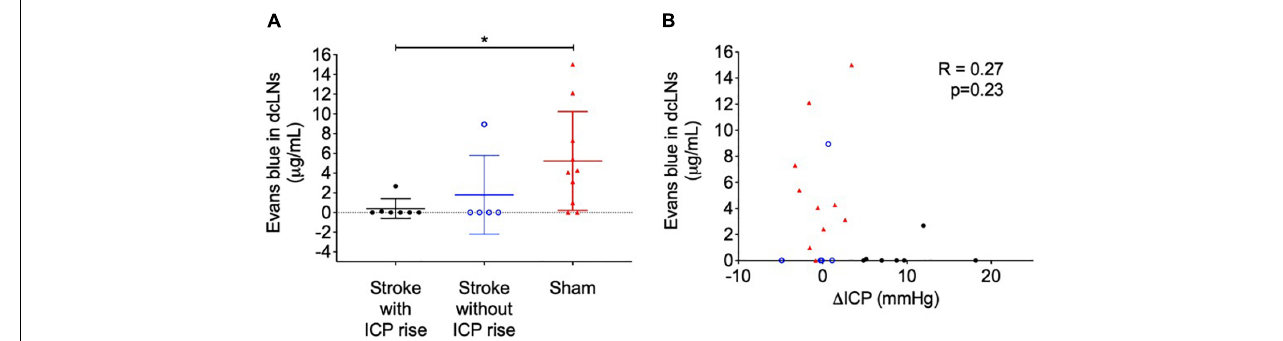
FIGURE 4 | (A) Concentration of Evans blue dye extracted into formamide ( µ g/mL) from deep cervical lymph nodes (dcLNs) of stroke animals with intracranial pressure (ICP) rise greater than +4.4 mmHg (black closed circles), stroke without ICP rise (blue open circles), and sham (red triangles) animals. * p ≤ 0.05, Kruskal-Wallis test with post hoc Dunn’s test between groups. (B) Relationship between (cid:49) ICP (mmHg) and the concentration of Evans blue dye in dcLNs. A Spearman correlation was used for analyses.